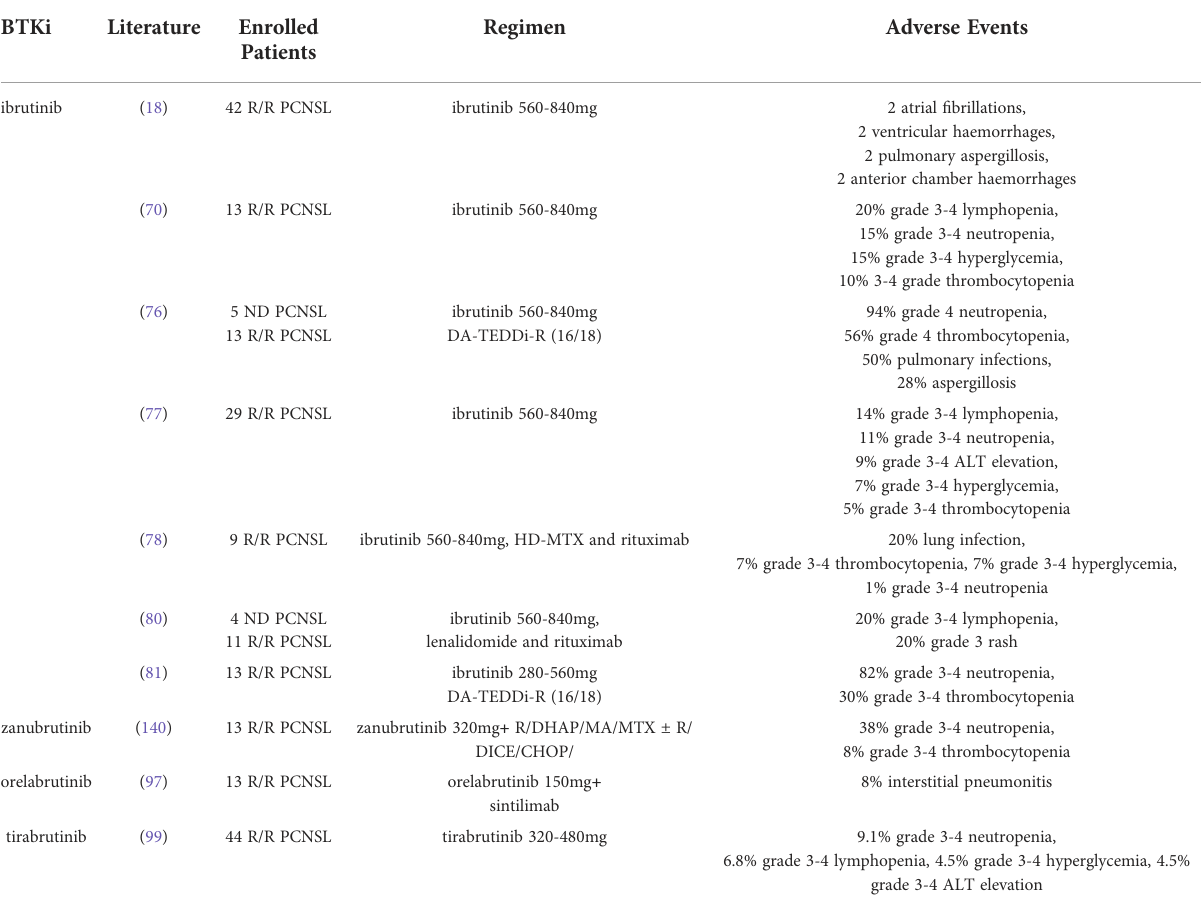
Table 2 BTK inhibitor adverse events. BTKi